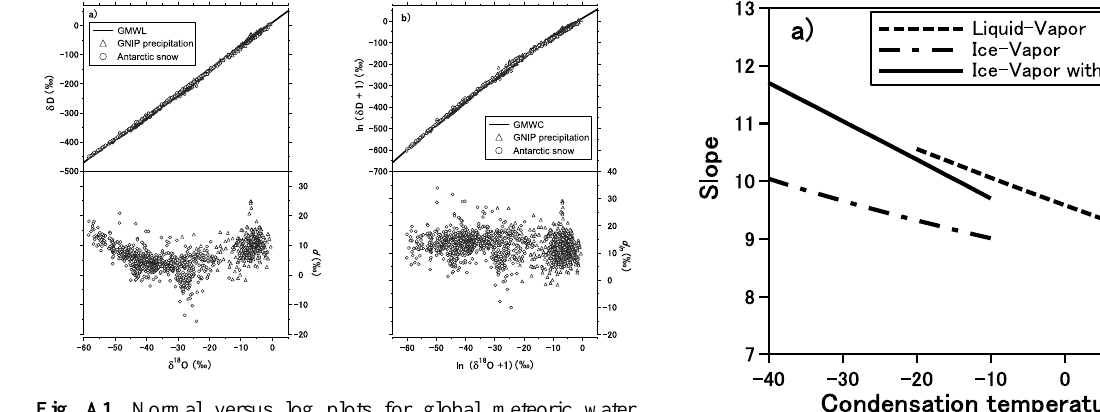
Fig. A1. Normal versus log plots for global meteoric water. (a) GMWL data from GNIP and Antarctic surface snow. GNIP data is based on 308 stations whose data contains the d data longer than 2yr. The GNIP data weighted by amount of pre- cipitation give a recession line ( δ D = 8.18 × δ 18 O + 11.2 ( R 2 = 0 . 991)). (b) Same as (a) but plot on the log plot. All the data give a regression curve (GMWC): ln ( 1 + δ D) = − 2.85 × 10 − 2 × (ln (1+ δ 18 O)) 2 +8.47 × ln (1+ δ 18 O)+13.3 ( R 2 =0.999).